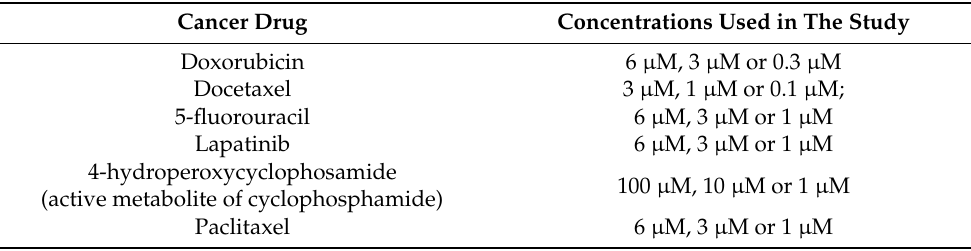
(active metabolite of